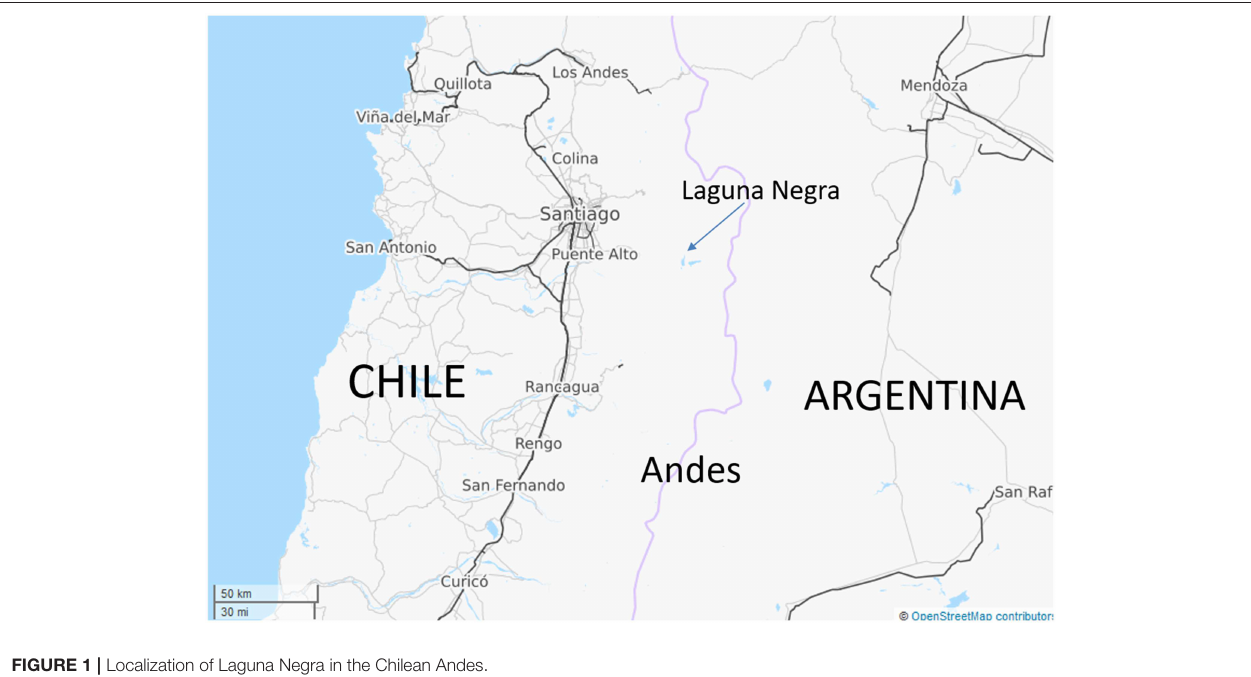
FIGURE 1 | Localization of Laguna Negra in the Chilean Andes.